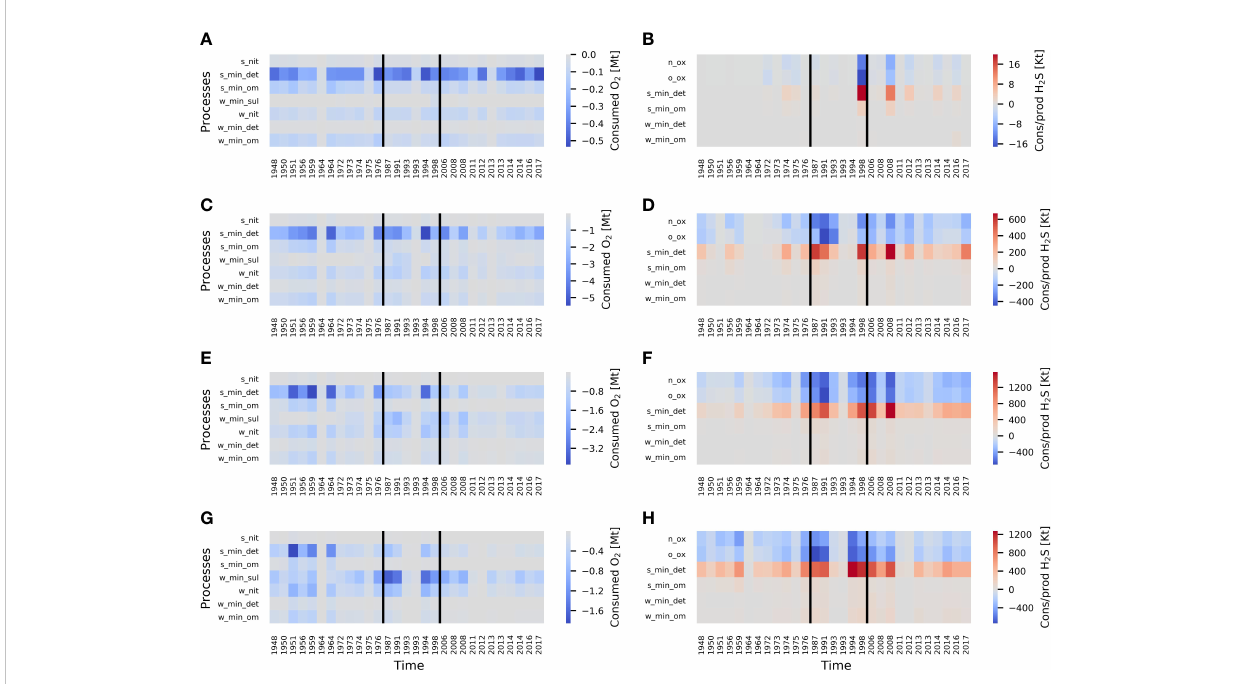
FIGURE 8 Temporally integrated oxygen consumption (negative values) panels ( A, C, E, G ) and hydrogen sul fi de consumption (negative values) and production (positive values) panels ( B, D, F, H ) by a speci fi c term during saltwater in fl ows for each sub-basin (spatially integrated within the sub-basin). Integration was carried out for the total daily consumption or production by a certain budget term. For each sub-basin integration started when a certain in fl ow reached that sub-basin and stopped when either all O 2 transported by the in fl ow is consumed or the water of the new in fl ow reached the sub-basin. Processes should be read according to the following rule: the fi rst part of the name shows the domain (w – water column and s -sediments), second and third parts – the type of process. For example, S_min_det should be read as detritus mineralization in the sediments. Respiration by phytoplankton and zooplankton as well as photosynthesis were excluded from the analysis due to their pronounced seasonality and their unimportance for the oxygen budget (see Section 3.1). X-axis shows the years when the in fl ows begin and therefore is not equally spaced but sticks to the chronological order. Black lines denote stagnation periods. Panels (A, B) stand for the Bornholm Basin, (C, D) – for the eastern Gotland Basin, (E, F) – for the northern Gotland Basin, (G, H) – for the western Gotland Basin. Mt corresponds to 10 9 kg. Kt corresponds to 10 6 kg. See Supplementary Tables 1, 2 for the de fi nition of the names of